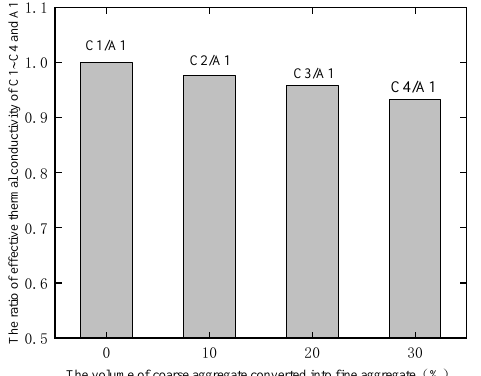
Figure 10. The effective thermal conductivity ratio of C1~C4 to A1.